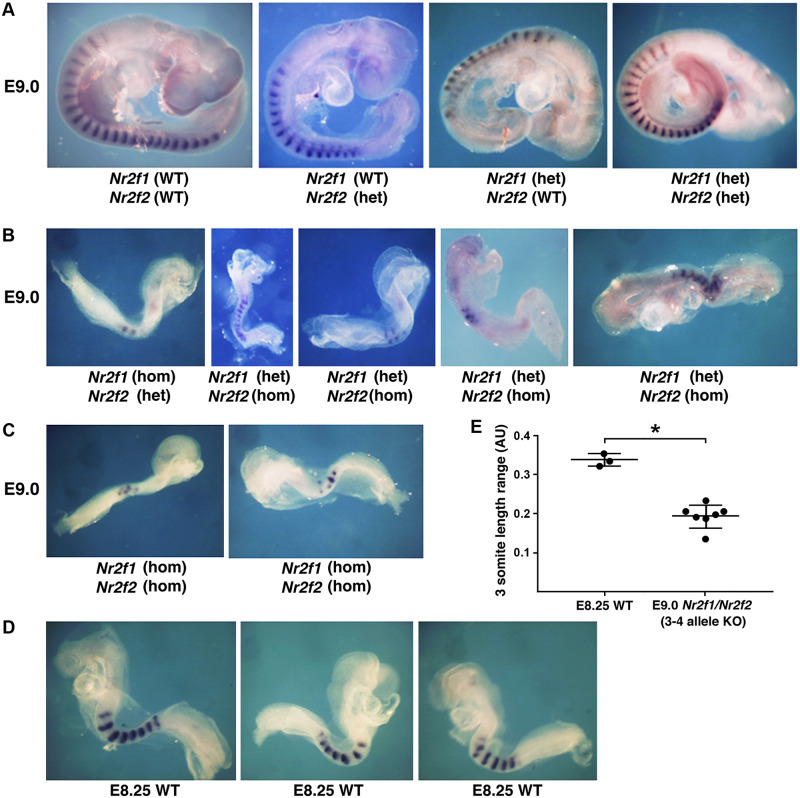
Nr2f1/Nr2f2 double mutants exhibit defects in body axis formation.(A) Embryos dissected at E9.0 carrying 0–2 knockout alleles for Nr2f1 or Nr2f2 have normal somites and body axis formation based on expression of the somite marker Uncx. (B-C) Embryos dissected at E9.0 and stained for Uncx that carry 3 or 4 knockout alleles for Nr2f1 or Nr2f2 exhibit small somites and reduced body axis growth resembling the size of embryos at E8.25. (D) WT E8.25 embryos stained for Uncx expression. (E) Comparison of somite size along the anteroposterior axis between E8.25 WT and E9.0 Nr2f1/Nr2f2 knockout embryos (3–4 knockout alleles); *p < 0.05, data expressed as mean ± SD, 1-way ANOVA (nonparametric test); WT, n = 3 biological replicates; Nr2f1/Nr2f2 3–4 allele double knockout, n = 7 biological replicates. Data associated with this figure can be found in S1 Data. AU, arbitrary units; E, embryonic day; het, heterozygous; hom, homozygous; Nr2f1, nuclear receptor 2f1; Nr2f2, nuclear receptor 2f2; SD, standard deviation; WT, wild-type.